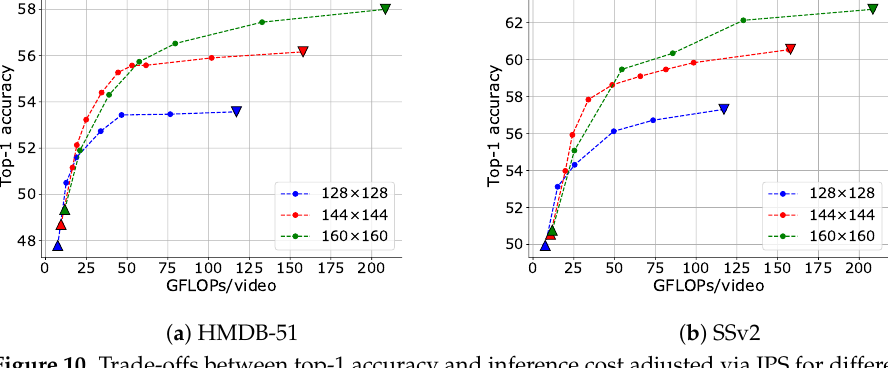
Figure 10. Trade-offs between top-1 accuracy and inference cost adjusted via IPS for different input frame resolutions. The data point with the highest FLOPs for each setting is obtained when no input reduction is performed (upper bound), and the data point with the lowest FLOPs is obtained when only I-frames are input (lower bound). The upper and lower bounds are plotted as inverse triangles and triangles,